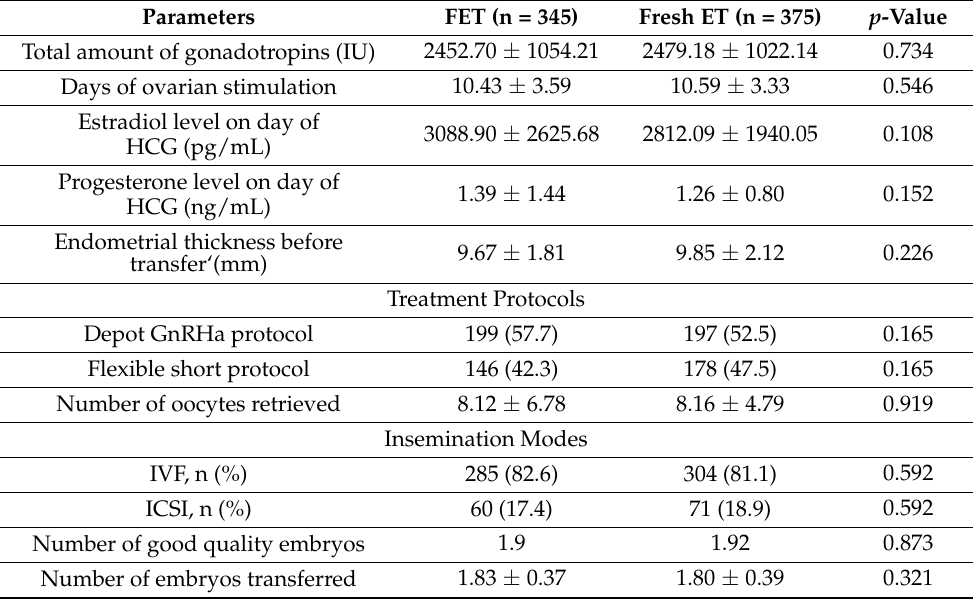
Table 2. Outcomes of controlled ovarian hyperstimulation.